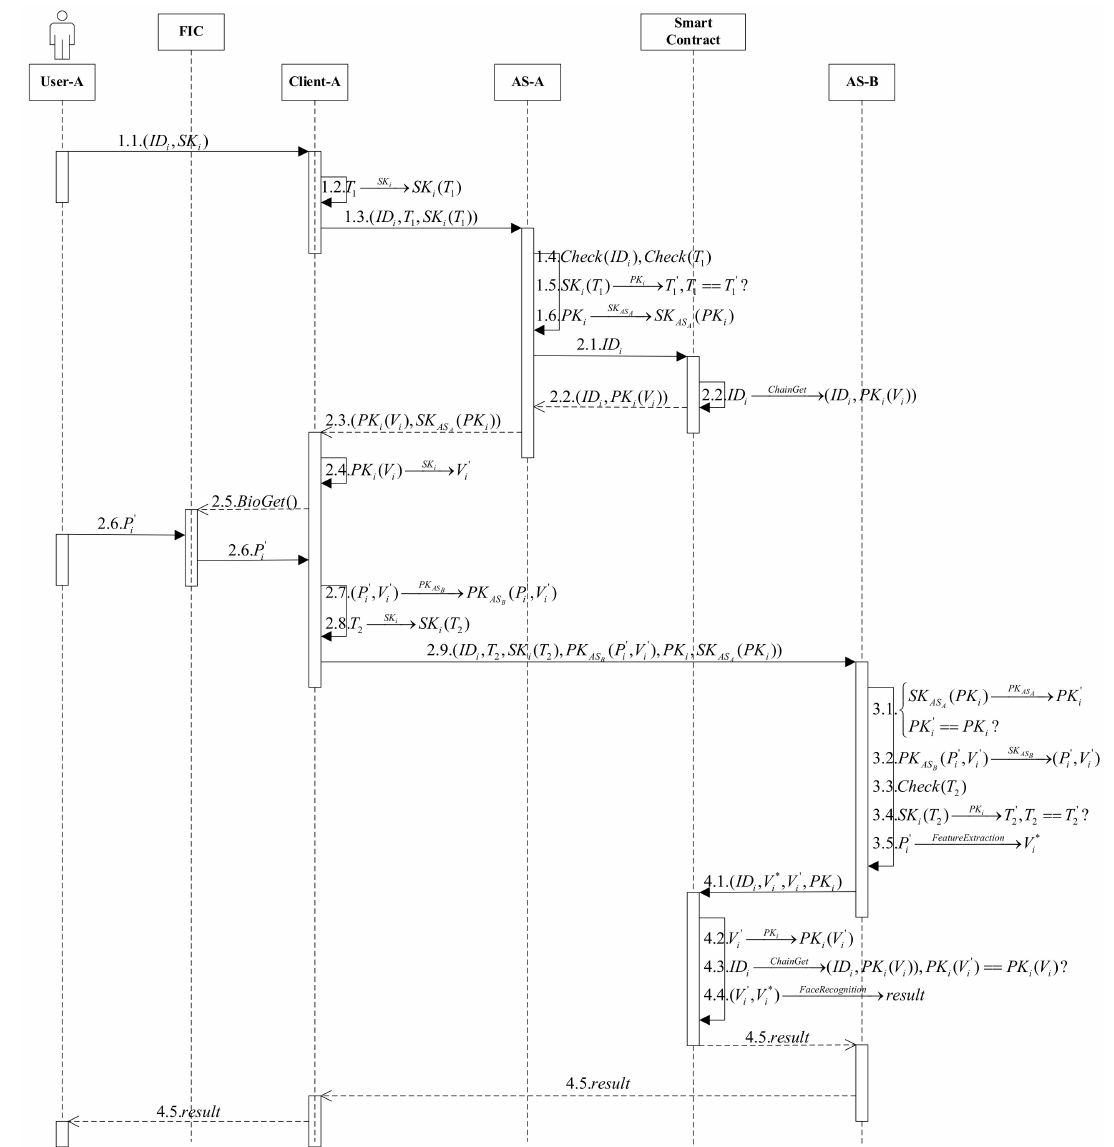
Figure 7. Cross-domain authentication process. The user sends the cross-domain authentication request to the local domain AS node, and the local AS node signs the user certificate and returns. Then the user sends the face information and the certificate signature to the target domain AS for cross-domain authentication. The target domain authenticates the user’s certificate signature and the face information and finally returns the authentication